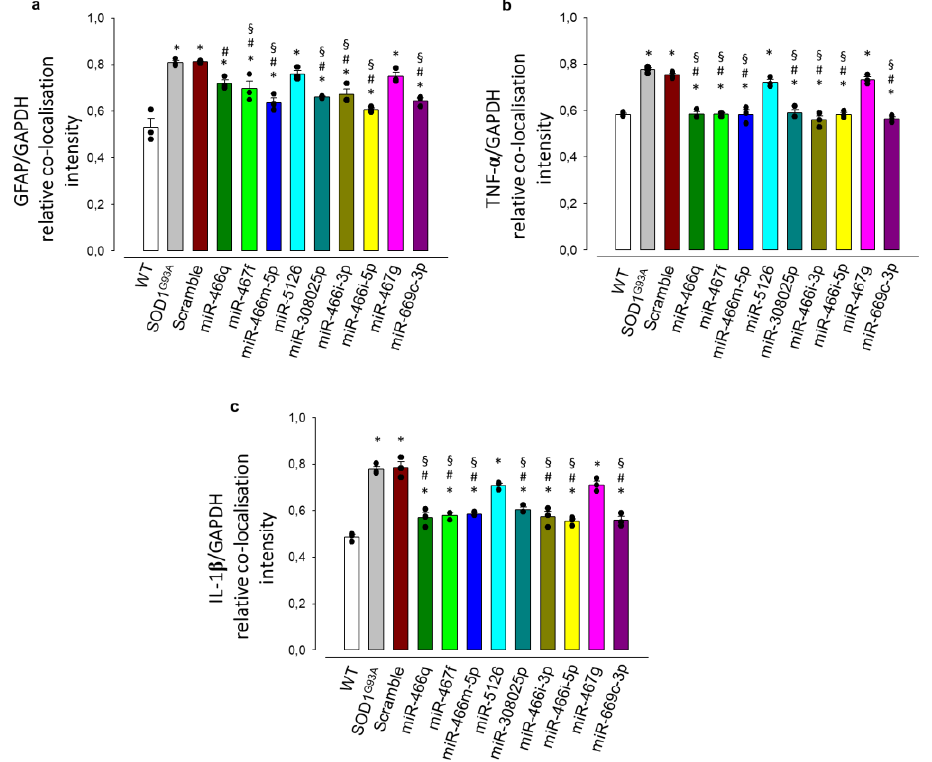
Figure 6. miRNAs shuttled by EVs mediate the reduction of astrogliosis and inflammatory cytokines expression in SOD1 G93A astrocytes. ( a – c ) Quantitative representation of protein expression as per relative fluorescence intensity with respect to the stable housekeeping protein GAPDH. The quantitative analyses of the relative co-localization intensity of fluorescence correlated with the protein expression level were performed as described in the legend to Figure 2. ( a ) GFAP, ( b ) TNF- α and ( c ) IL-1 β expression are significantly increased in untreated or scramble -miRNA-treated SOD1 G93A as- trocytes vs. WT astrocytes. The exposure to seven out of nine specific synthetic mimics of miRNAs shuttled by EVs significantly reduces the expression of the GFAP, TNF- α, and IL - 1β, indicating a decreased astrocyte reactivity. Data are presented as means ± SEM of n = 3 independent experiments, run in triplicate; statistical significance for p < 0.05 at least (* p < 0.001 vs. WT astrocytes; # p < 0.001 vs. SOD1 G93A astrocytes; § p < 0.001 vs. SOD1 G93A astrocytes + scrambled miRNA; F (11,24) = 17.967, F (11,24) = 49.372, F (11,24) = 38.634, for GFAP, TNF- α, and IL - 1β, respectively; one -way ANOVA, followed by Bonferroni post hoc test). We subsequently assessed the anti-inflammatory effect of four miRNAs (miR-466q, miR-467f, miR-466m-5p, miR466i-3p) which were found upregulated both in IFNγ - primed-MSCs and in their derived EVs [45]. According to our recent publication, and us- ing the miRWalk and KEGG & Panther Classification System databases [45], we focused on the effect of the four mimics on components of the p38 MAPK signalling pathway that is involved in the production of pro-inflammatory cytokines [65], including Map3k8 (tar- get of miR67f, 466i-3p, 466m-5p), Mk2 (target of miR-466q and miR-466i-3p) (Figure 7a), and Mapk11, which promotes TNF- α and IL- 1β synthesis through phosphorylation of the downstream activating transcription factor-2 (ATF-2) [66,67] (Figure 7b). RT-PCR analysis showed that none of the four mimics reverted the increased expression of Mapk8 and Mk2